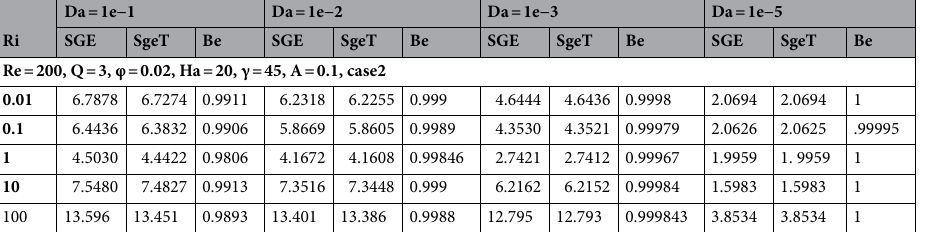
Table 11. Effect of Ri, Da on the entropy parameters for Case 2.